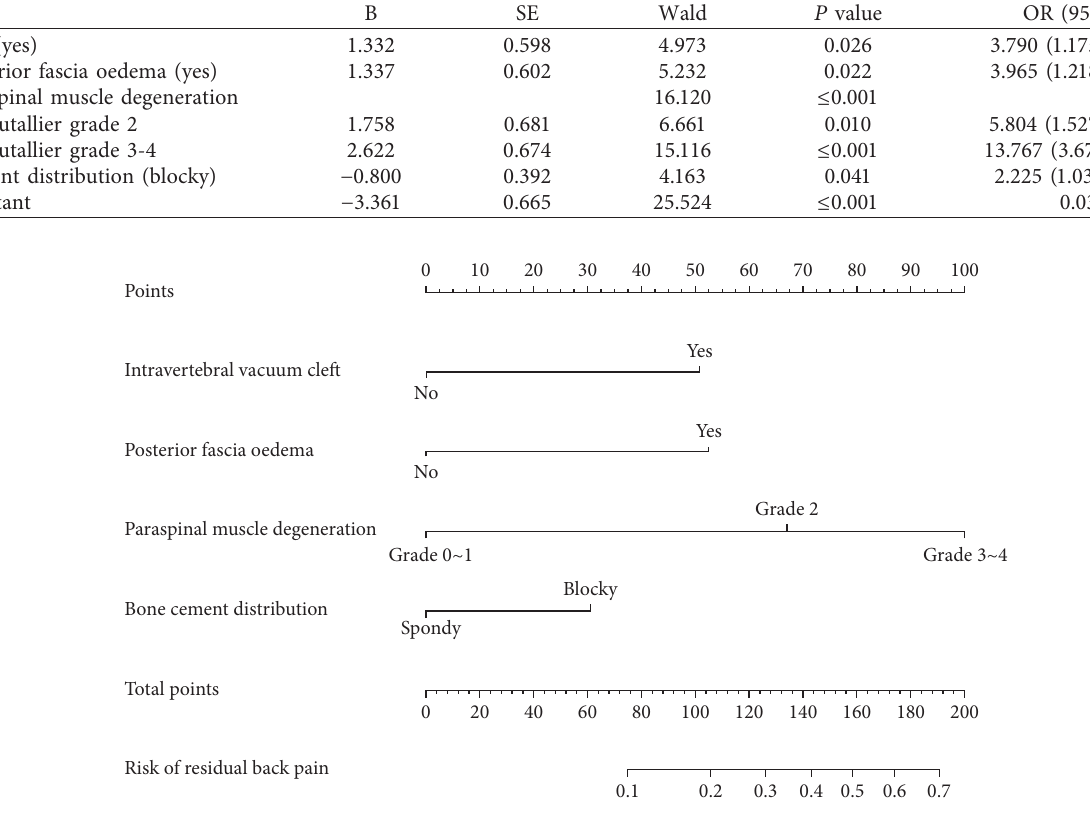
Figure 8: Predictive nomogram for residual back pain after percutaneous vertebroplasty.